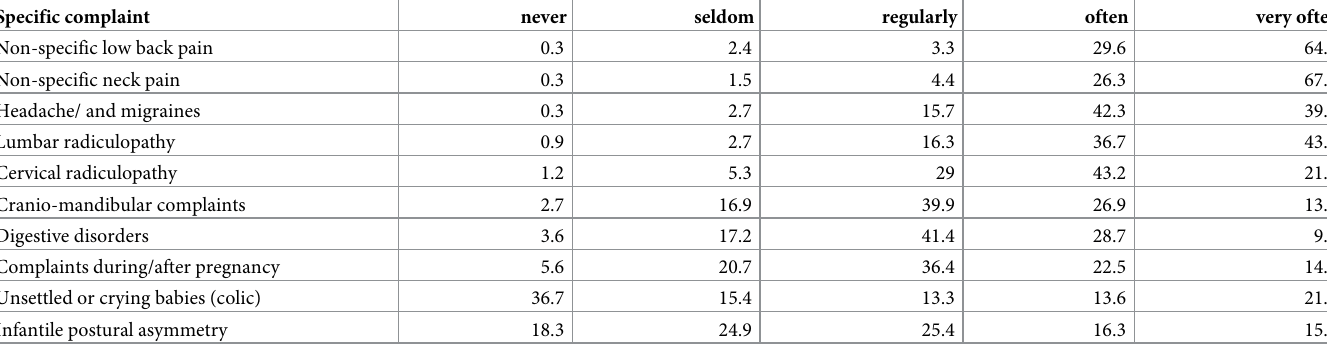
Table 4. The ten most common specific complaints (in descending order of ‘often’ and ‘very often’